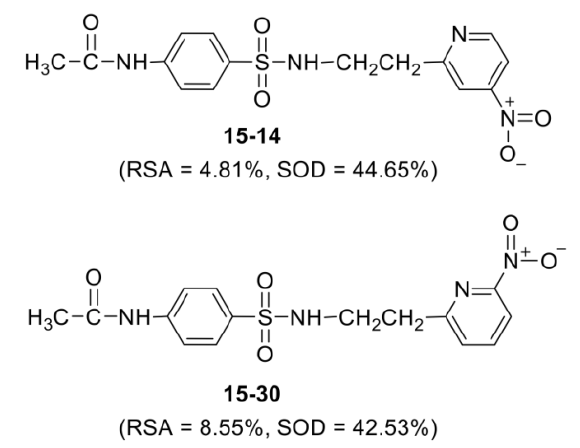
Figure 3: New designed nitrosulfona- mides with RSA and SOD